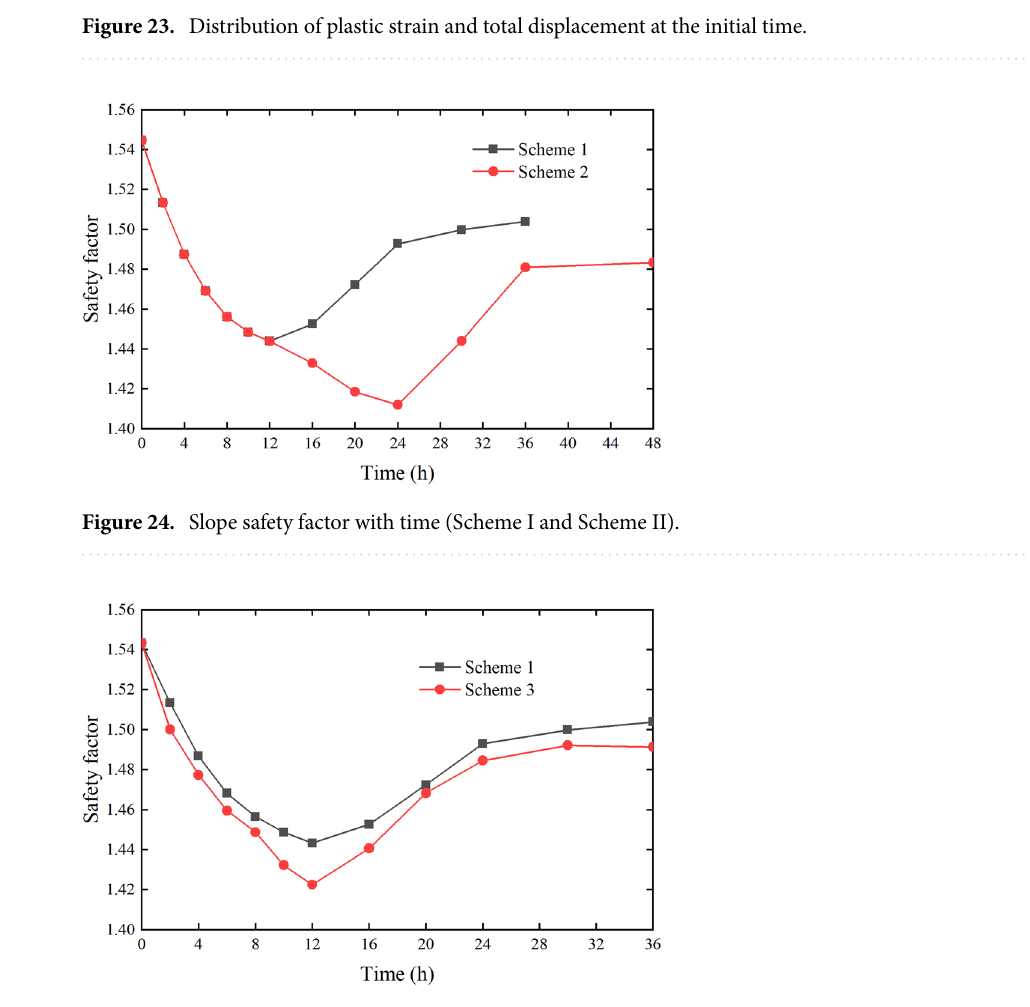
Figure 25. Slope safety factor with time (Scheme I and Scheme